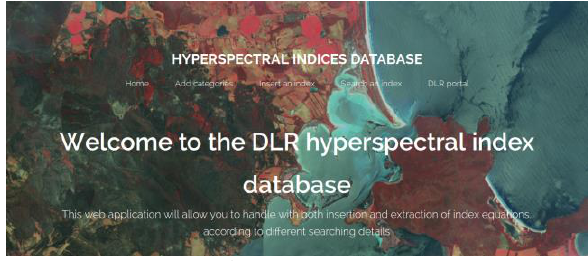
Figure 2. Homepage of the web-based tool, containing direct access to all functionalities.